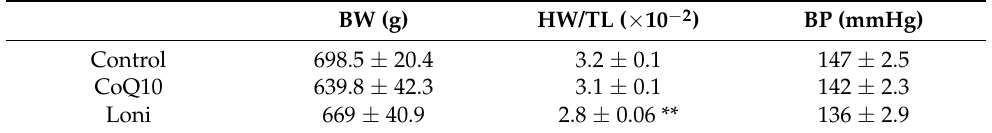
Table 2. The overview of body weight (BW), heart weight (HW)/tibia length (TL) ratio, and blood pressure (BP) in the control, coenzyme Q10 (CoQ10), and Lonicera caerulea L. (Loni) groups. BW (g)